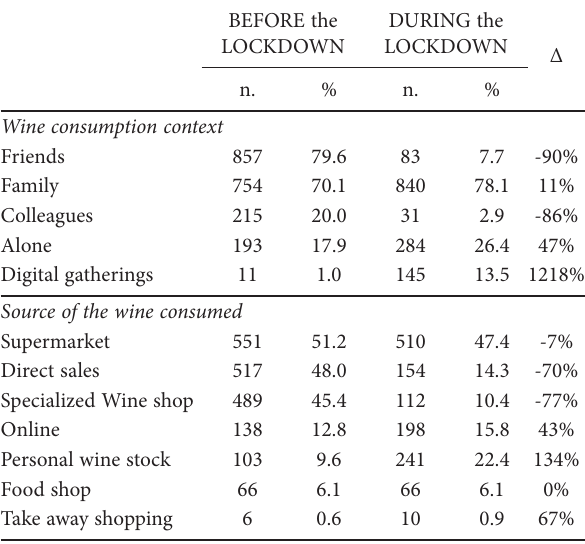
Table 3. Evolution of consumption contex and sale channel before and during the lockdown.